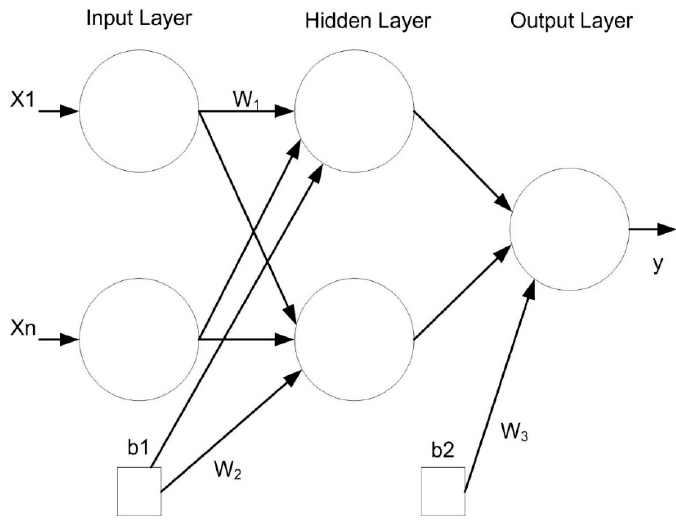
Figure 4. MLP model structure.